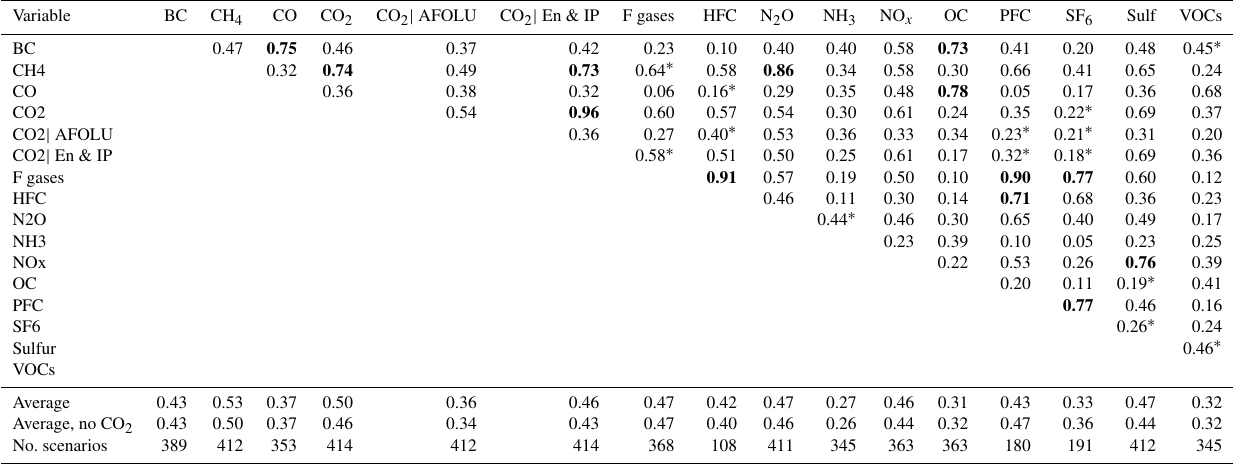
Table 3. Absolute values of Spearman’s rank correlation between emissions, averaged over the start of decades from 2020 to 2100. We use the following abbreviations: BC as black carbon; VOCs as volatile organic compounds; AFOLU as agriculture, forestry, and other land use; and En & IP as energy and industrial processes. “CO 2 |” represents subtypes of CO 2 . We also calculate the average of these rows, with or without the CO 2 and subtypes. Cells are bold if the value in them is > 0.7 and have asterisks if the variance of the rank correlation between years exceeds 0.03. There is no overlap between these categories.